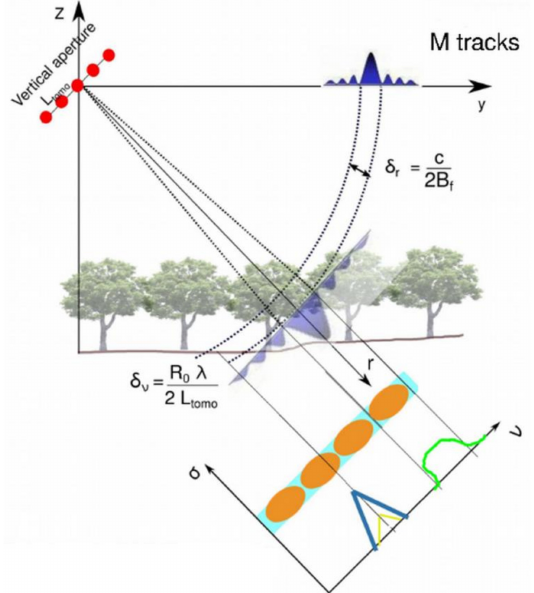
Figure 4. Principle of SAR tomography, which synthesizes, for each azimuth position, 2D resolution cells in the slant-range and cross-range directions, with resolutions δ r and δ ν ,